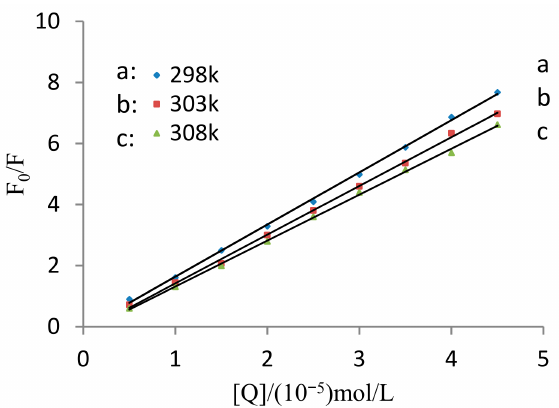
Figure 2. Stern-Volmer equation curve for the quenching of TRP by MC at different